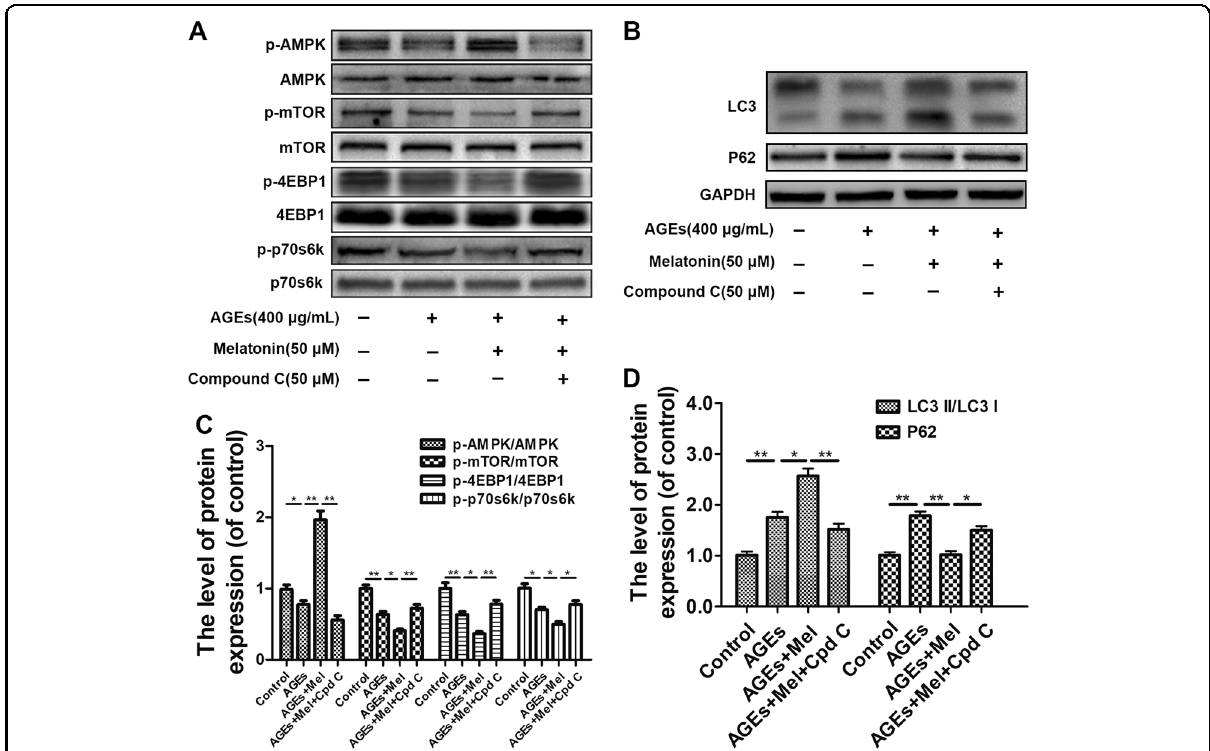
Fig. 5 Melatonin promotes autophagy fl ux by activating the AMPK/mTOR pathway in AGE-treated EPCs. EPCs were pre-treated with 50 μ M melatonin and 50 μ M Compound C (Cpd C) for 2 h. Next, 400 μ g/mL AGEs were added for an additional 6 h. a , c Representative Western blots and quanti fi cation data of p-AMPK/AMPK, p-mTOR/mTOR, p-p70s6k/p70s6k, and p-4EBP1/4EBP1 of each group treated with AGEs, melatonin, and Cpd C. b , d Representative Western blots and quanti fi cation data of LC3 and P62 of each group treated with AGEs, melatonin and Cpd C. Data are presented as the mean ± SEM. Signi fi cant differences between the treatment and control groups are indicated as ** P < 0.01 or * P < 0.05. n =